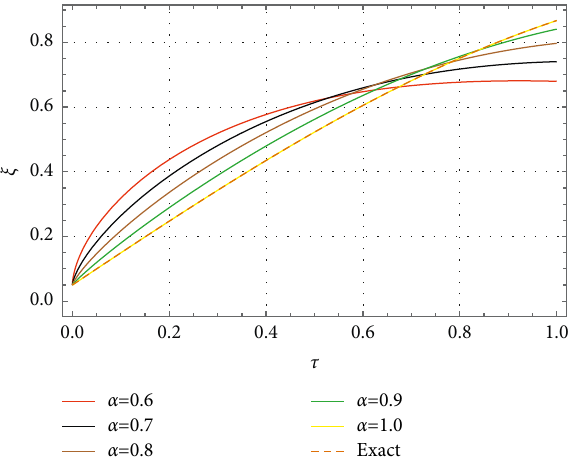
Figure 2: The approximate and exact solutions to the imaginary part of Example 1.